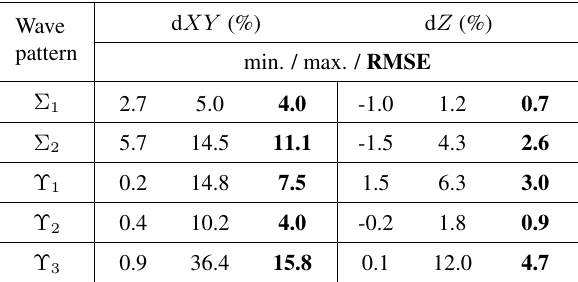
Table 2: Planimetric and depth coordinate displacement (in per- cent of water